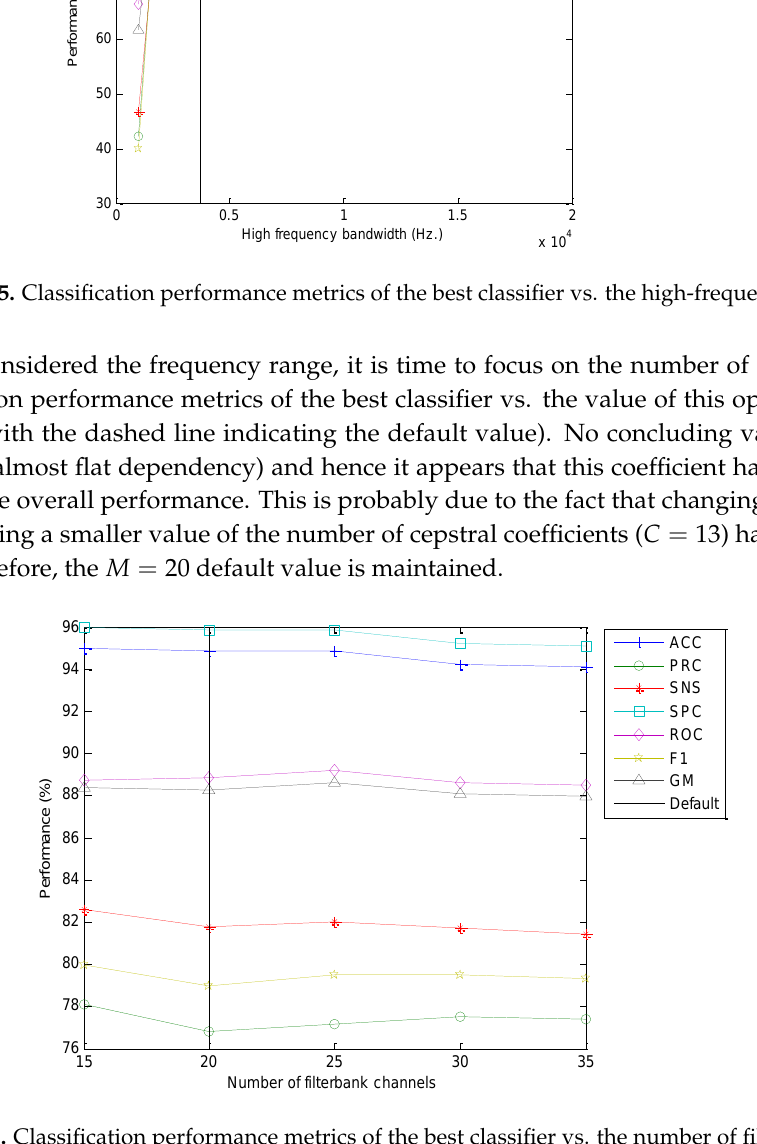
Table 7. Classification performance metrics vs. filter bank frequency scaling.